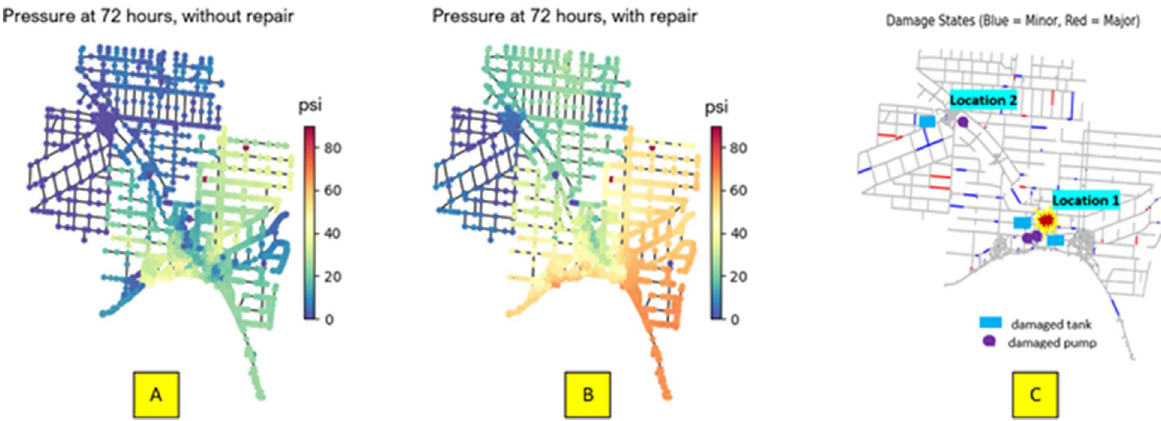
Figure 6. M-City WDN under a 5.5 M earthquake at Location 1. ( A ) Network junction pressure 24 h after the earthquake in the case of no repairs. ( B ) Network junction pressure 24 h after the earthquake in the case of repair strategy, RS2. ( C ) Network damaged components for this